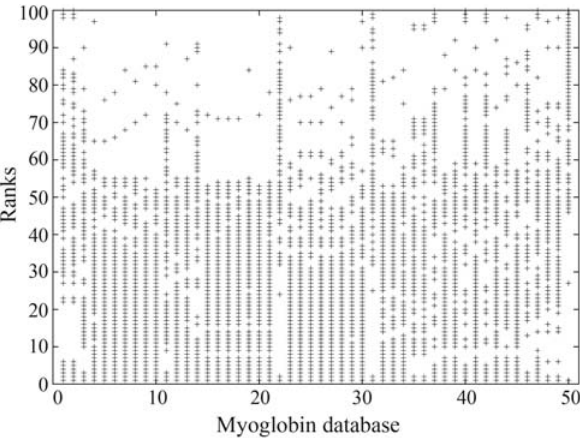
Figure 6 - This figure shows all the ranks as lines and each column repre- sents a chain of the database. A point in the picture means that the chain in thatspecificpositionoftherankisamyoglobin.Theabsenceofpointindi- cates that the chain in that position is not a